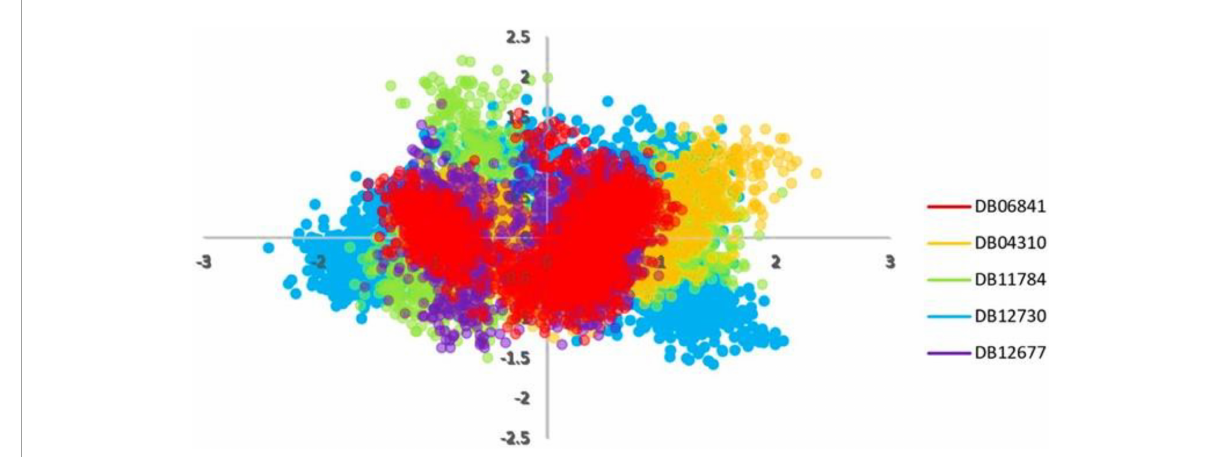
FIGURE7 PCA analysis for MD simulation trajectories. Adopted from BioRender.com.